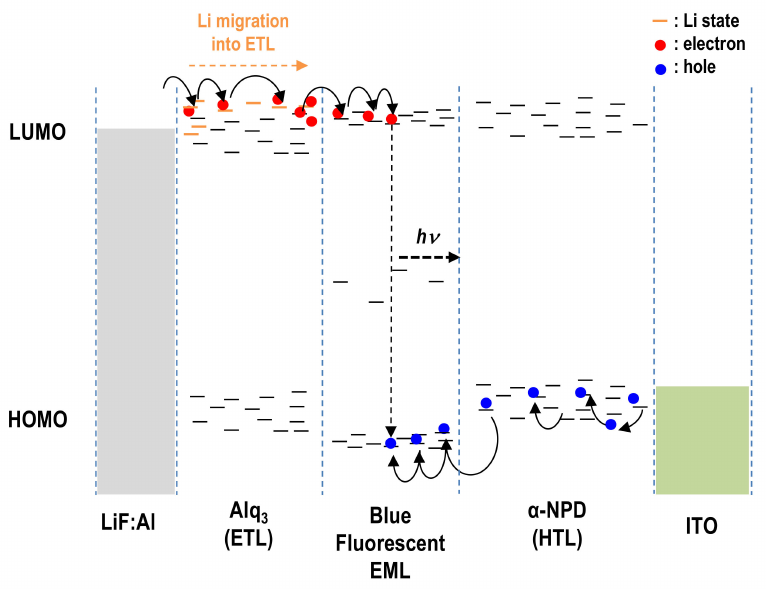
Figure 9. Schematic diagram of Li ion migration in the device, leading to the enhancement of